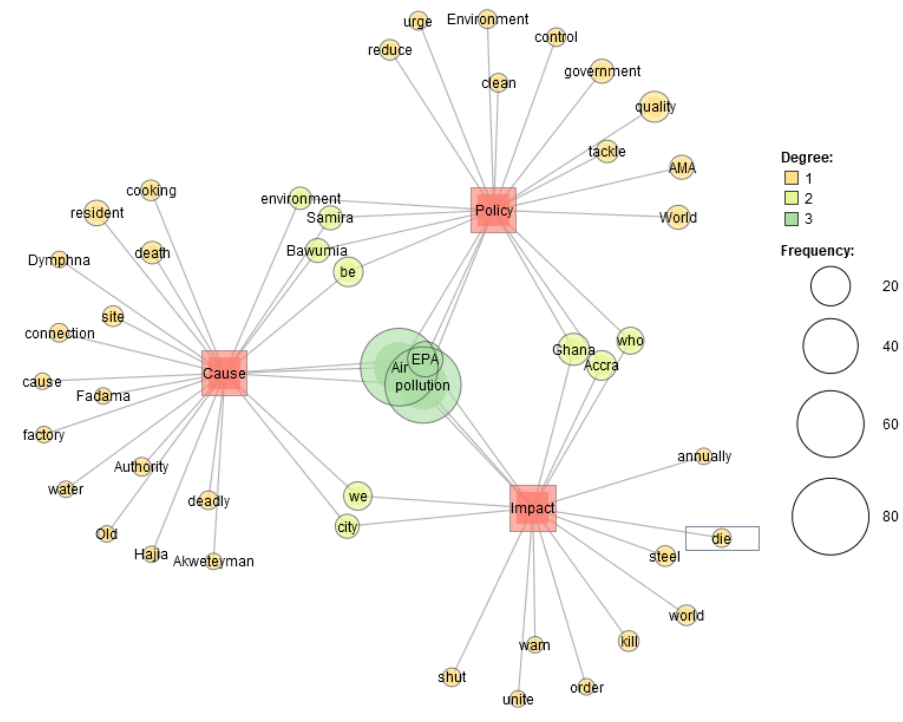
Figure 7. Semantic Network of air pollution publications by thematic focus.